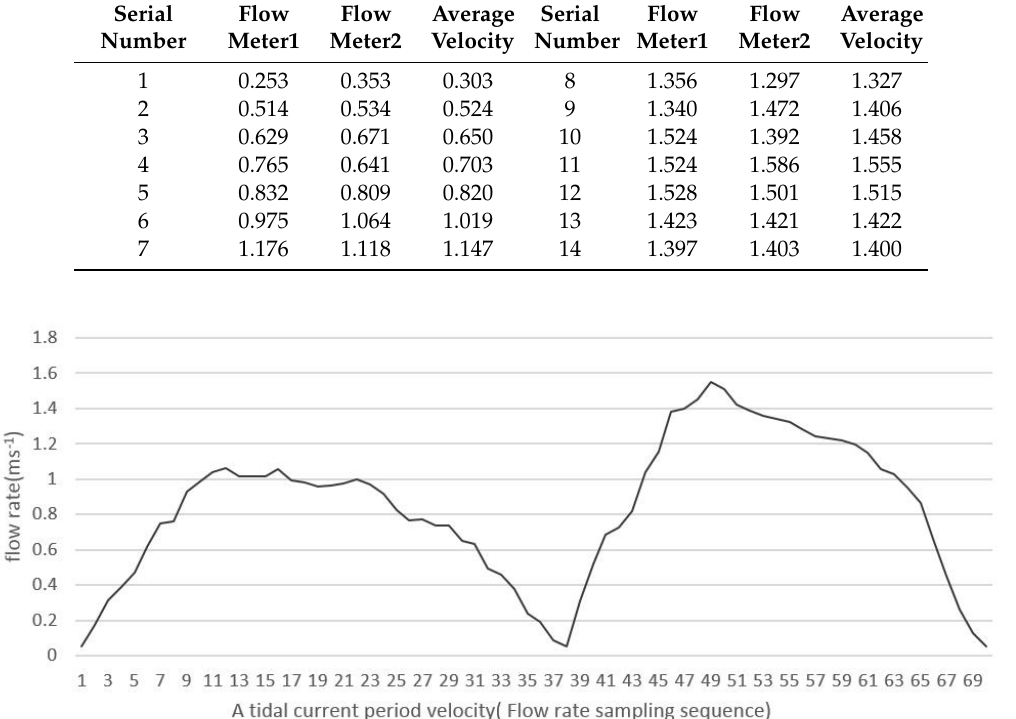
Figure 5. A tidal current period velocity in the applied sea area.